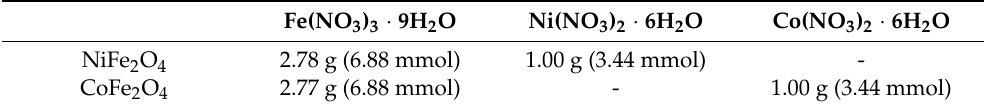
Table 5. Weight (g) of the reactants used during the preparation of the magnetic spinel